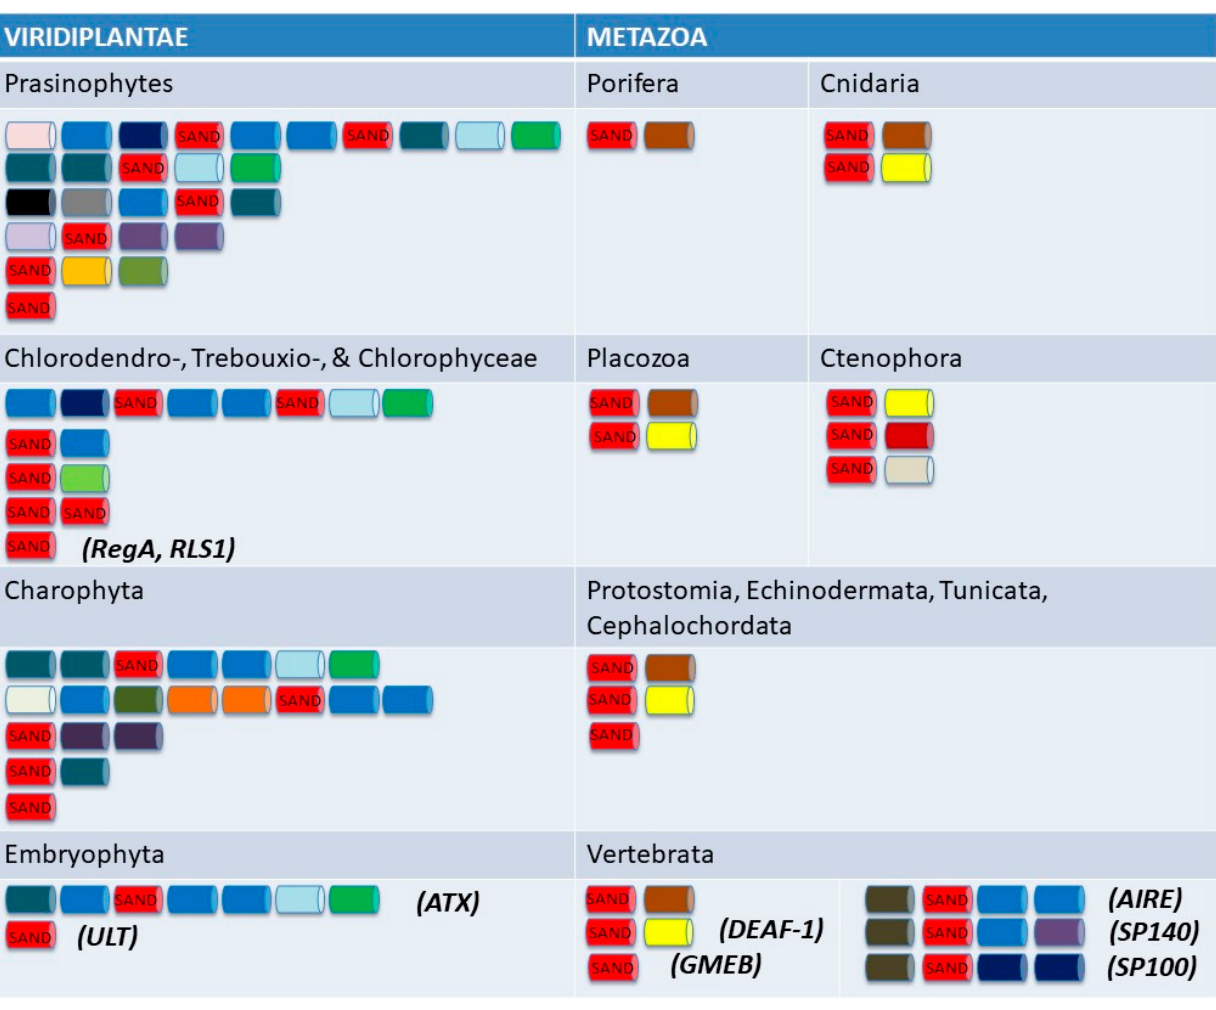
Figure 6. Most common domain architectures in SAND-domain-containing proteins present in the main Viridiplantae and Metazoa lineages showing differences in domain architectures between green alga/plant and animal SAND-containing proteins (various colors indicate the different domains found in specific proteins and lineages; for domain names see the study by Nedelcu [71]). Examples of proteins with known functions are indicated in parentheses. Adapted from the study by Nedelcu